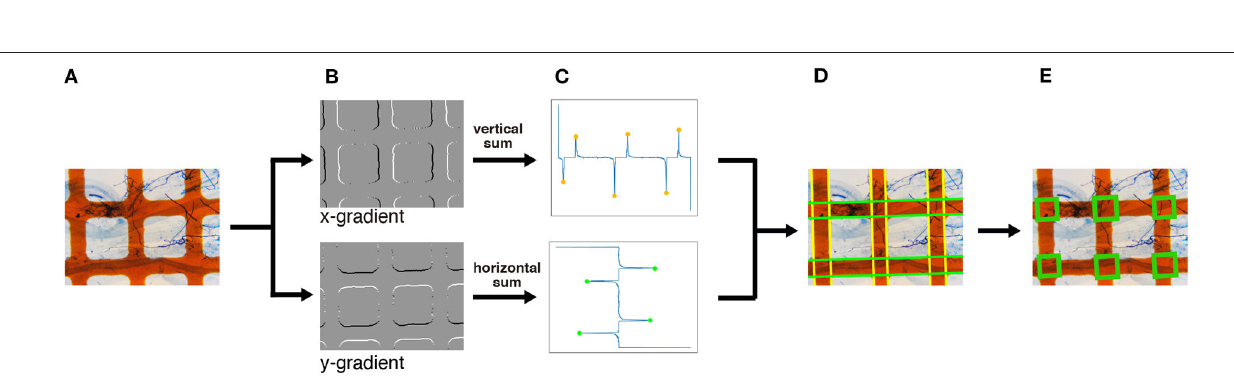
connected (FC) layer to the end of the pretrained CNN model, we fine-tuned the model in the task of categorizing the training images into four